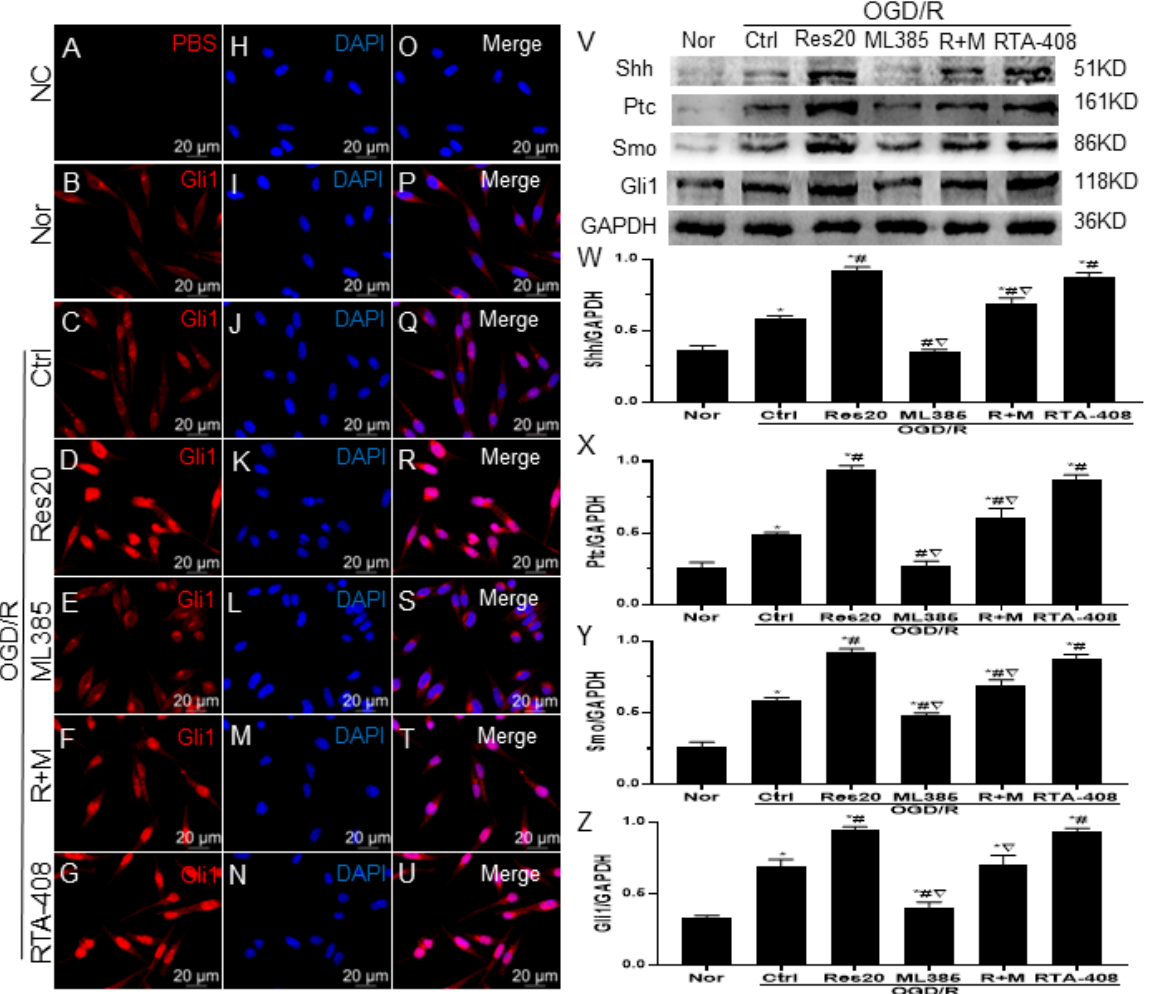
Figure 5. Nrf2 signaling mediates resveratrol to affect Shh signaling pathway in microglia. ( A-G ): Microglia were immunostained with antibodies to Gli1 (red). ( H-N ): Nuclei were labeled with DAPI (blue). ( O – U ): merges of A/H, B/I, C/J, D/K, E/L, F/M and G/N; Scale bars =20 um. ( V ): the expression of Shh, Ptc, Smo and Gli1 protein with Western blot. (W-Z): Quantitative analysis of Shh, Ptc, Smo and Gli1 protein levels. * p < 0.05 vs. Nor; # p < 0.05 vs. Ctrl; ▽ p < 0.05 vs. Res20. Data are presented as the mean ± standard deviation and were compared using a one-way analysis of variance ( n = 3 for each group). Nor, normal; Ctrl, control; Res20, 20 µ M resveratrol, ML385, Nrf2 inhibitor; R + M, 20 µ M resveratrol combination with ML385; RTA-408, Nrf2 agonist.